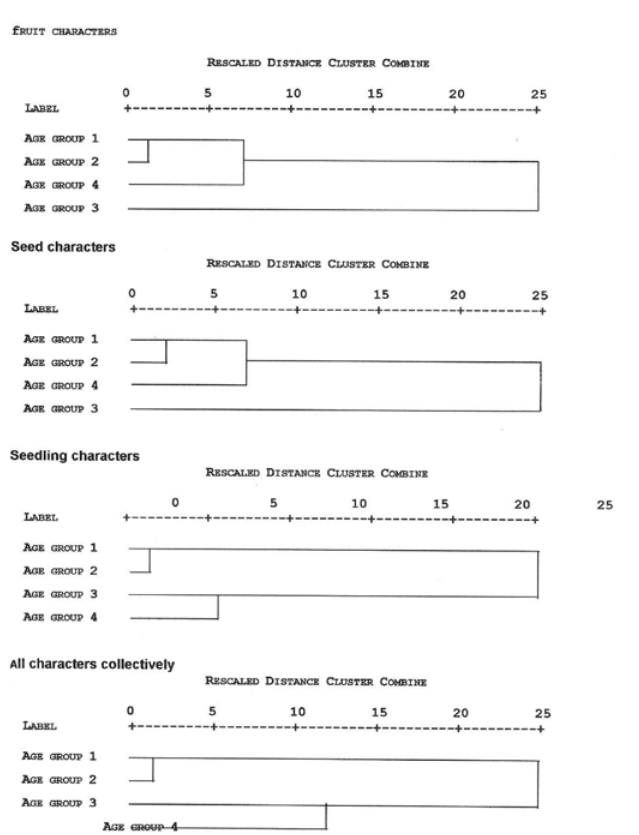
Fig. 5 - Dendrogram showing the similarity and proximity of the four age groups based on the fruit, seed and seedling characters individu- ally and collectively in mangosteen ( Garcinia mangostana L.).